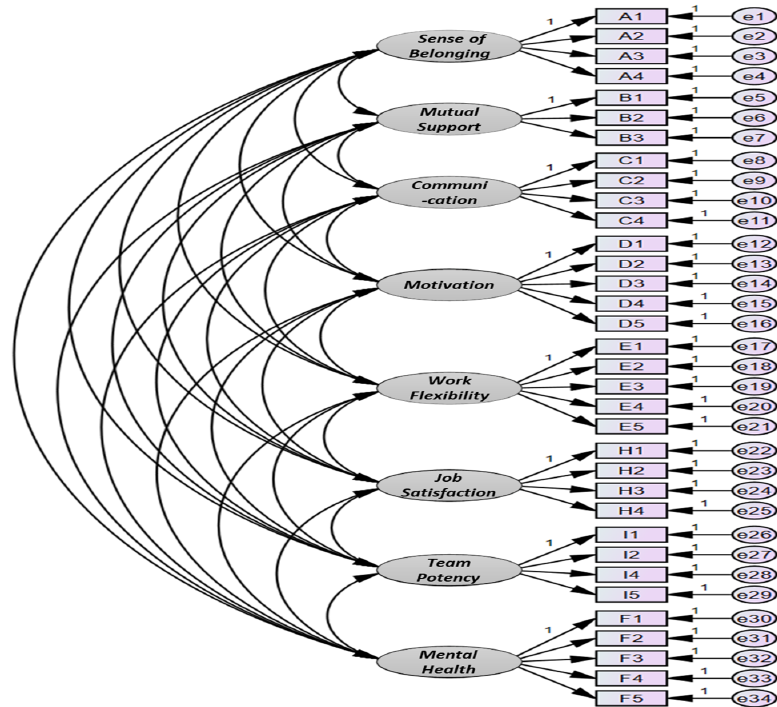
Figure 2. Confirmative factor analysis model.